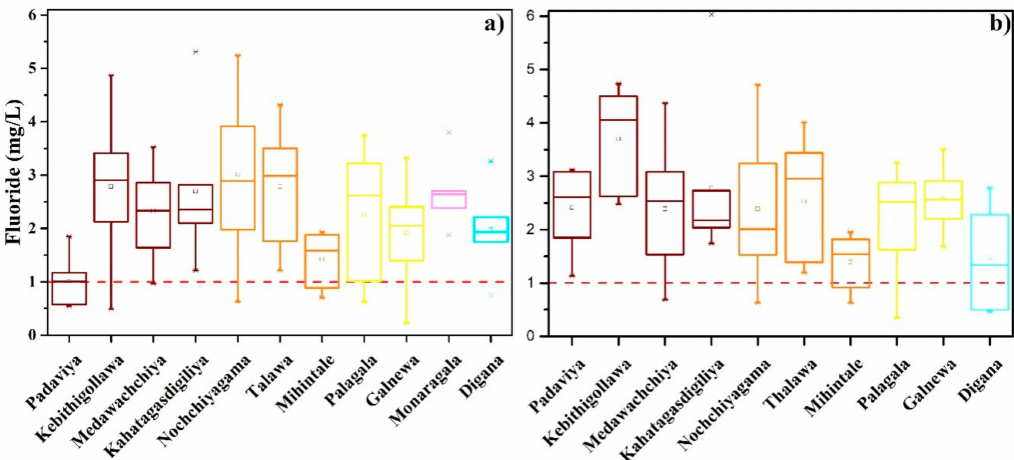
Figure 3. Box and whisker plot showing fluoride distribution in the samples of the wet season ( a ) and dry season ( b ) in study areas. The maximum allowable fluoride concentration at 1.0 mg / L of the SLS 614-2013 for potable water is shown. Di ff erent colours represent sampling areas, “*” denotes the maximum / minimum observations.